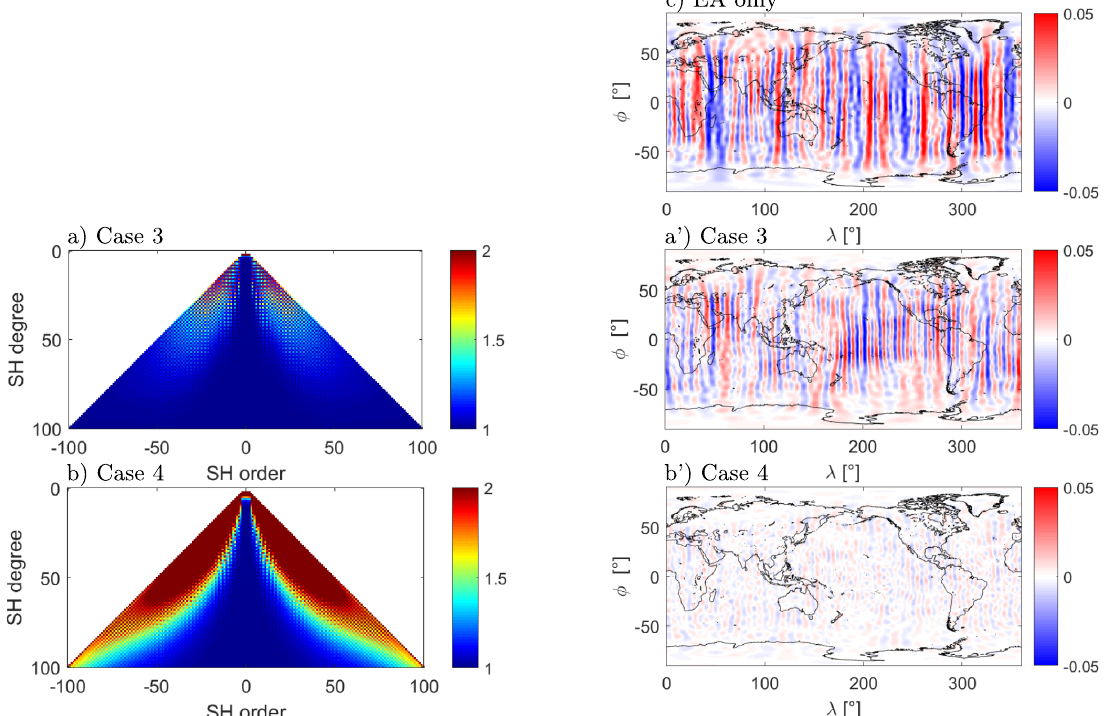
Figure 13. Relative improvement of the formal errors for Case 3 ( a ) and Case 4 ( b ) towards the EA scenario for a GRACE-type mission under consideration of the static gravity field signal and a hybrid accelerometer with a 1/ f 3 EA noise slope, as well as an EA corner frequency of 1 mHz. Global geoid height errors are shown for EA-only ( c ), Case 3 ( a’ ), and Case 4 ( b’